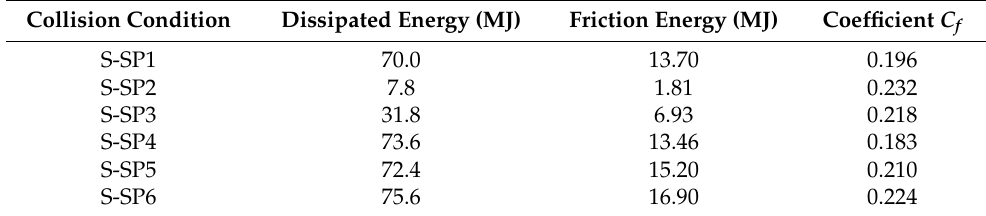
Table 10. The ratio of the friction energy to dissipated